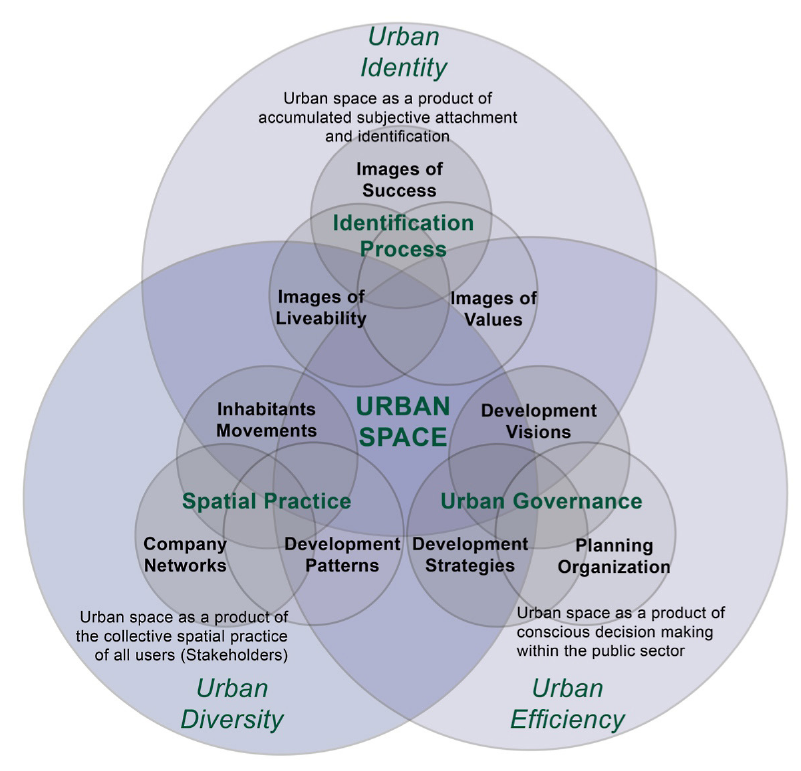
Figure 3. Framework utilising the Lefebvrian triadic conception of space in examining urbanism in the emerging city of Doha (Salama & Wiedmann,